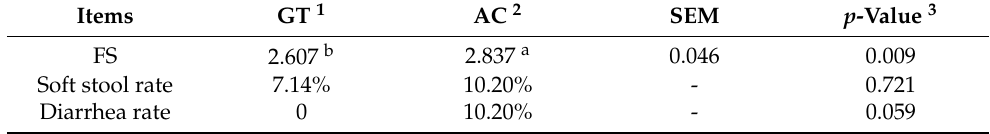
Table 2. Effects of different dietary change methods on FS, soft stool rate, and diarrhea rate.